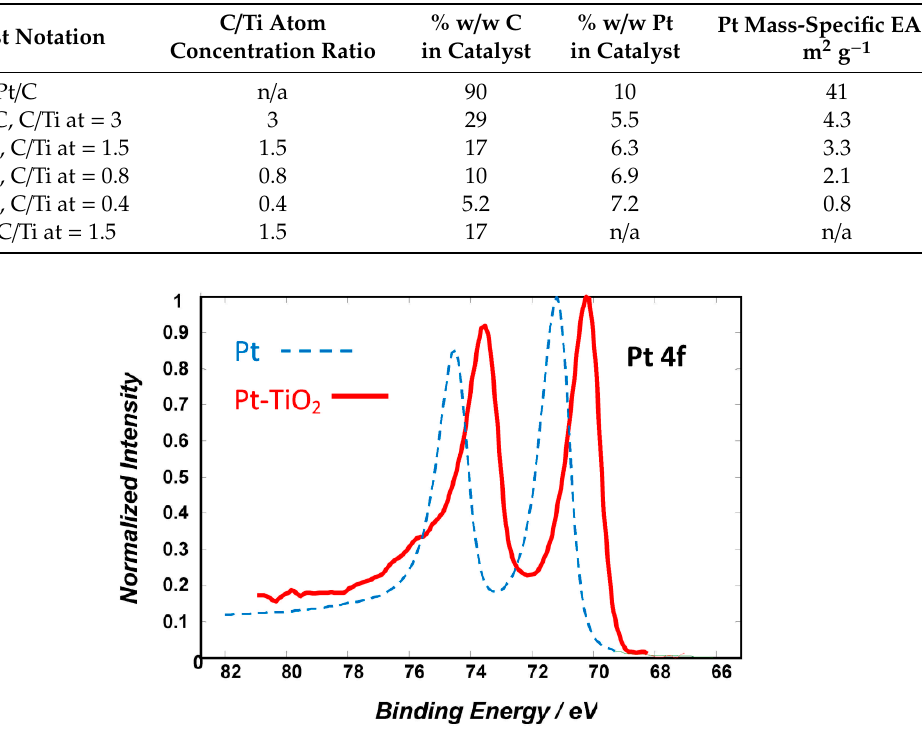
Figure 2. XPS spectra in the Pt 4f photoelectron binding energy range for the Pt-TiO 2 catalyst and a Pt foil reference.